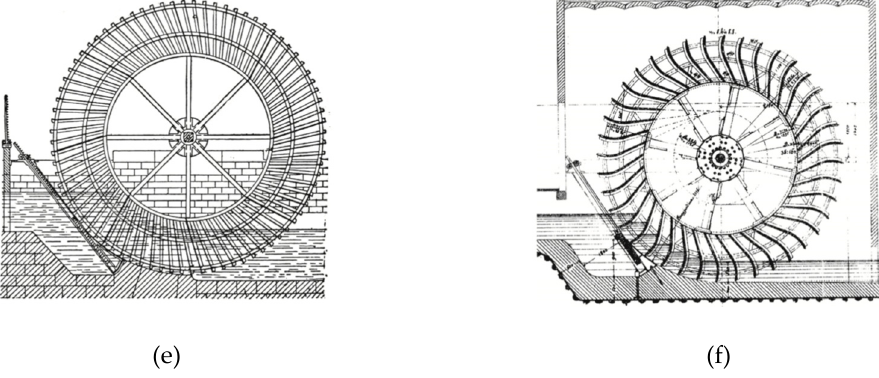
Figure 4. Types of gravity water wheels: (a) Overshot; (b) low breastshot; (c) high breastshot; (d) undershot; (e) Sagebien; (f) Zuppinger. Adapted from [17–19].